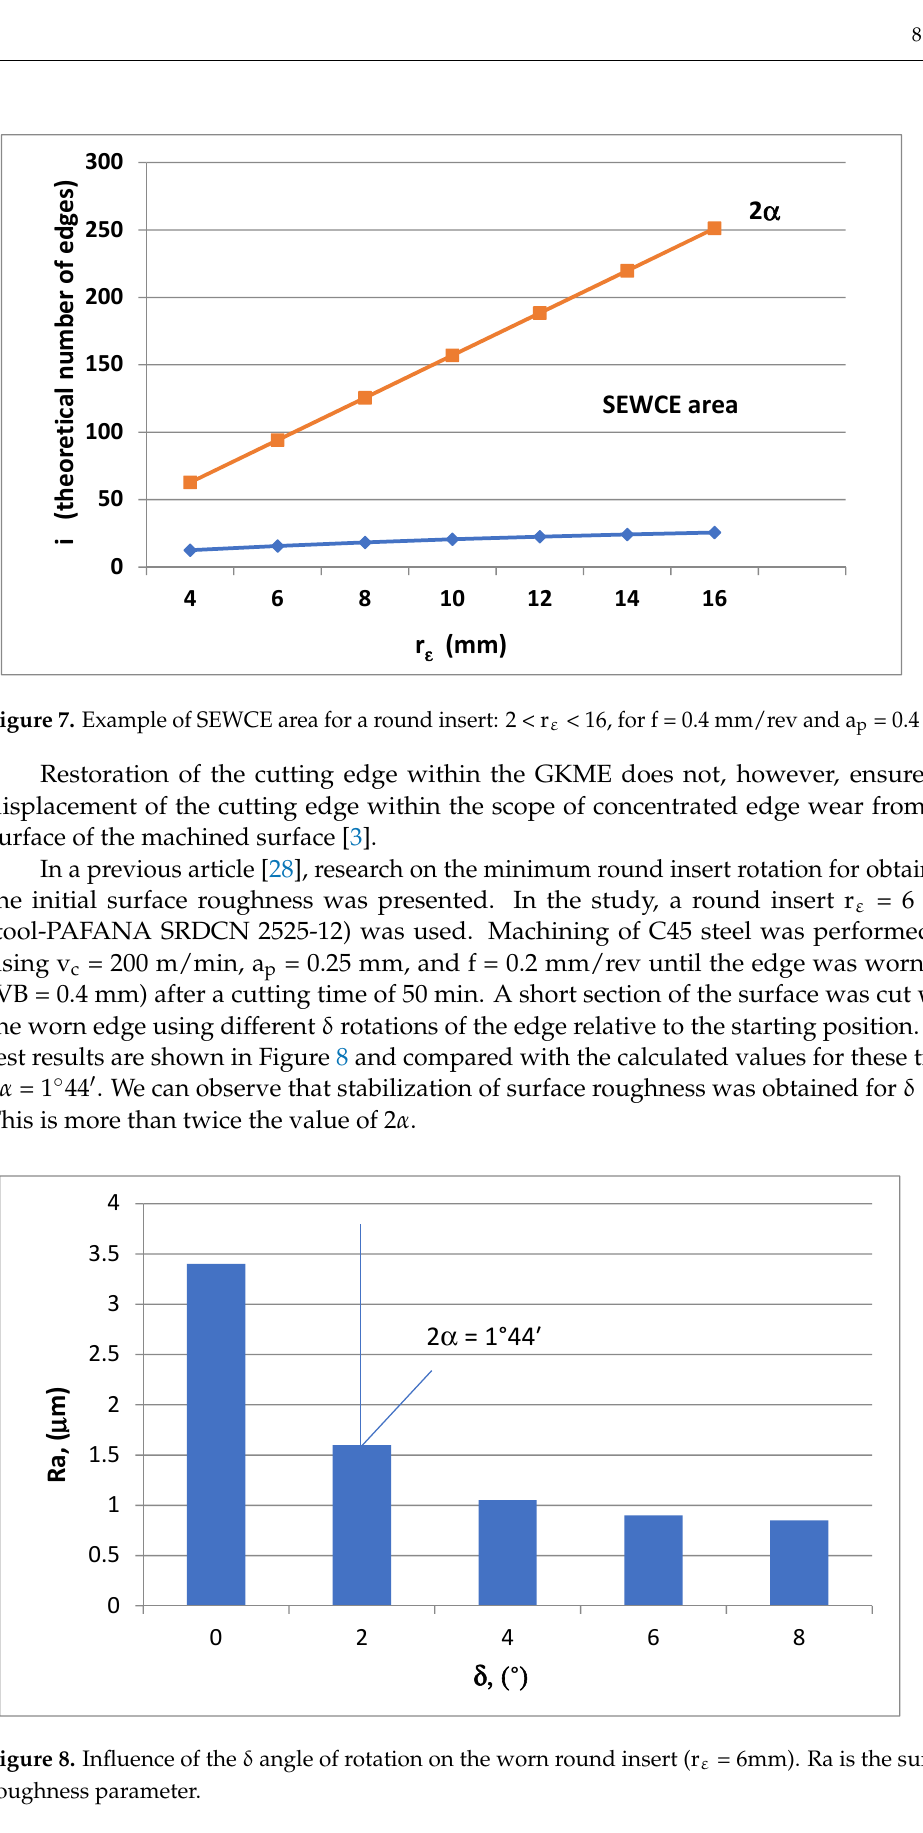
Figure 6. Theoretical number of edges determined by using the round insert δ = 2 α rotation for different r ε and f values.